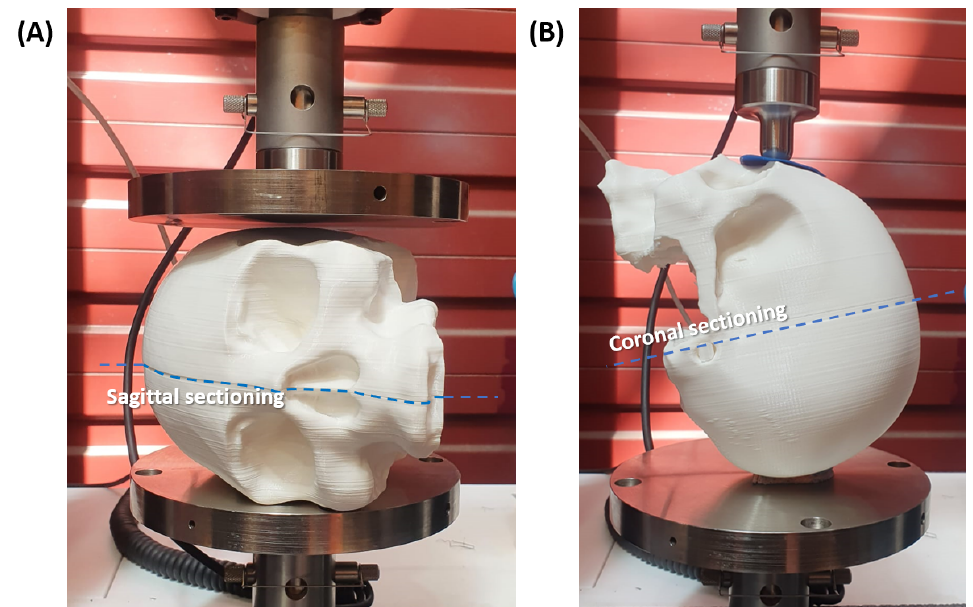
Figure 3. Experimental setup for ( A ) lateral compressive test, ( B ) frontal point-loading test. Anti-slip rubber pieces positioned on the contacting points of the skull with the testing